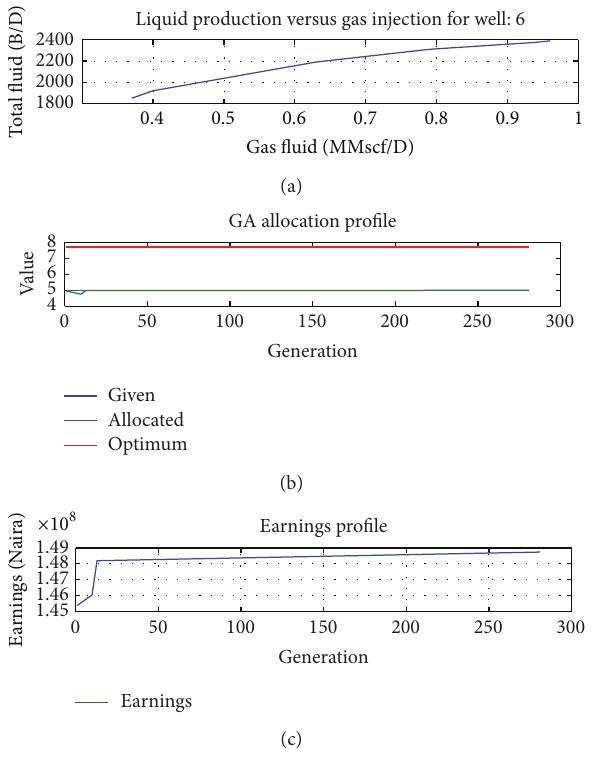
Figure 12: Well 6’s allocation profile, wells 1–6 GA allocation profile, and earnings (Naira) for a limited scenario.